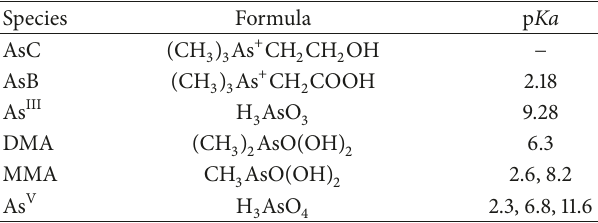
Figure 1: Chromatograms of arsenic speciation by gradient elution using mobile phase A: 1.25 mmol/L of Na 2 HPO 4 and 11 mmol/L of KH 2 PO 4 ; mobile phase B: 2.5 mmol/L of Na 2 HPO 4 and 22 mmol/L of KH 2 PO 4 , 20 𝜇 g/L for each arsenic speciation. Table 2: p Ka values and formulas of arsenic species